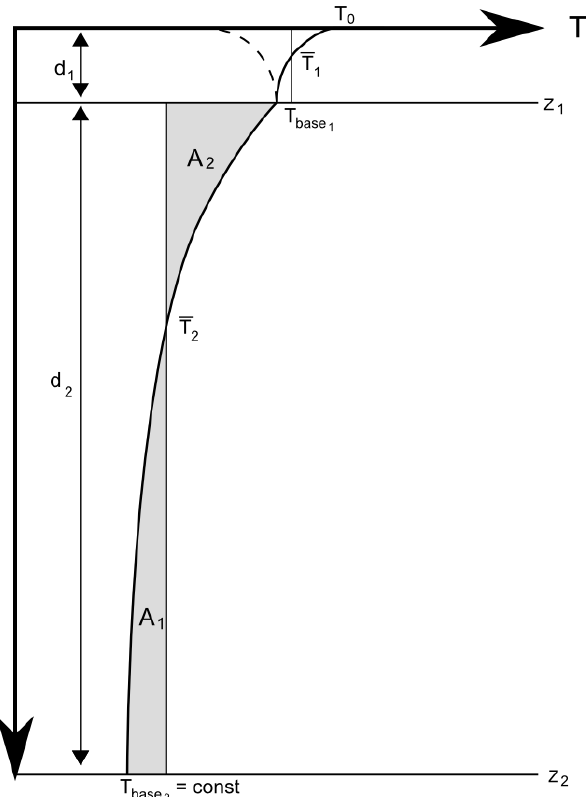
Fig. 4. Conceptional drawing of the assumed quadratic subgrid soil temperature profile and the associated parameters. In order to derive ¯ T ¯ T 1 and 2 geometrically the areas A 1 and A 2 must be